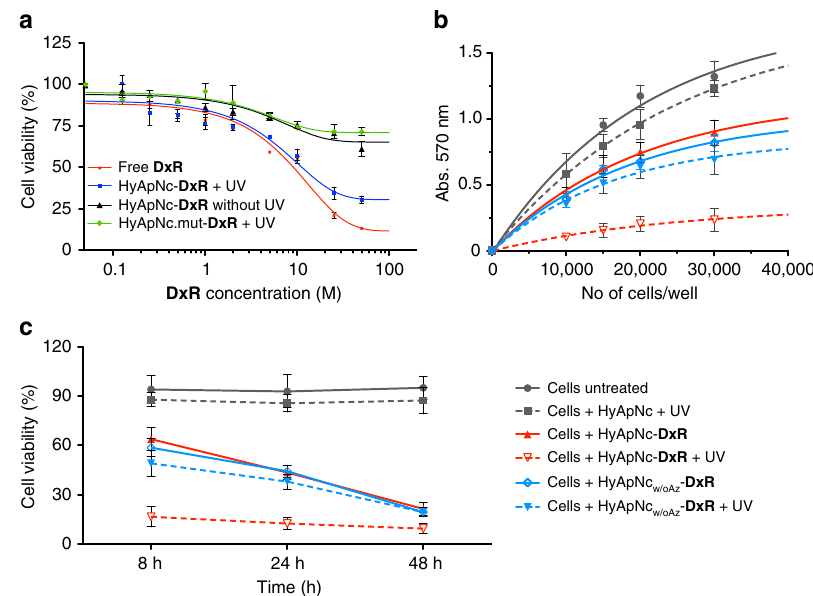
Fig. 8 Cell viability assays of DxR -loaded HyApNc nanoconstructs in NCI-H1838 cells. a Cytotoxicities of HyApNc – DxR and HyApNc.mut – DxR complexes in combination with UV irradiation at the indicated DxR concentrations (0.125 – 50 µ M ranges). As a control, viabilities of the cells treated with free DxR alone and HyApNc – DxR complex without UV irradiation were compared ( n = 2, error bars: mean ± S.D.). b 8 h post incubation MTT assays where an increasing number of H1838 cells treated with unloaded HyApNc (gray), photoactive HyApNc- DxR (red), and photo-inactive HyApNc w/oAz - DxR (blue) with and without subsequent UV irradiation (dashed vs. solid lines). As control, cell viabilities of the H1838 cells treated with RPMI medium with 10% FCS and not exposed to UV irradiation (gray solid) were measured at 570 nm ( n = 2, error bars: mean ± S.D.). c Time-dependent cytotoxicities of photoactive HyApNc- DxR (red) against photo-inactive HyApNc w/oAz - DxR (blue) with and without UV irradiation (dashed vs. solid lines) where the cells were treated with the DxR complex for various incubation times of 8, 24, and 48 h, respectively, before being subjected to the MTT assay ( n = 2, error bars: mean ± S.